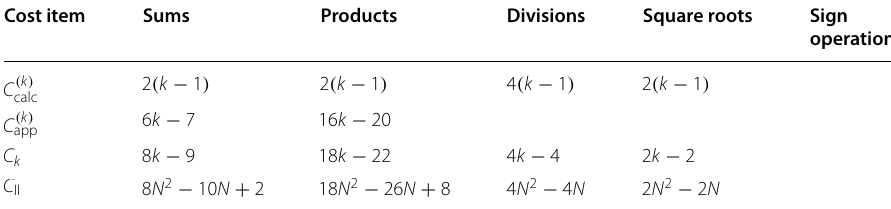
Table 4 Superdiagonal reduction computational cost Cost item